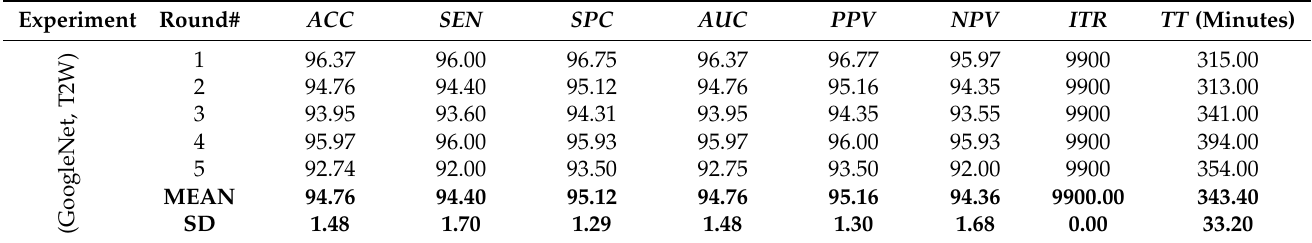
Table A12. Test results of five-folds of the experiment (GoogleNet, T2W).